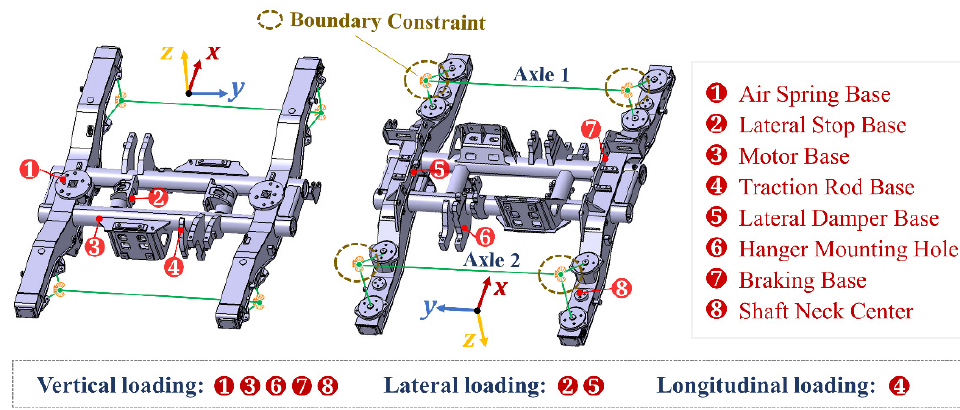
Figure 2. 3D model and boundary conditions.